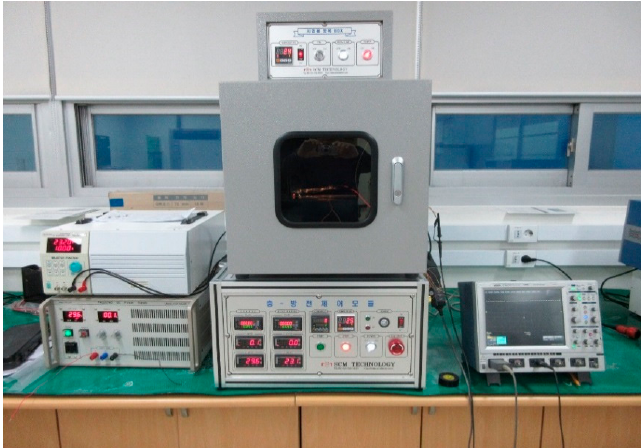
Figure 9. Charging and discharging durability test .